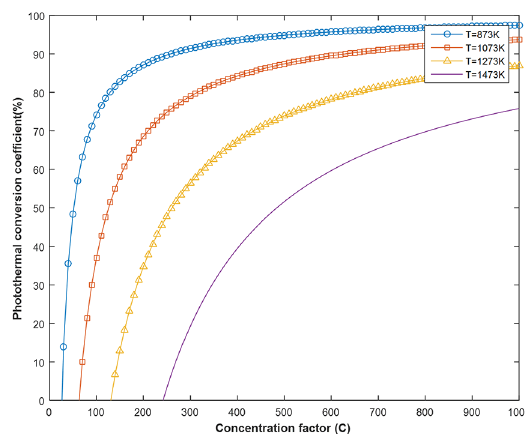
Figure 9. Photothermal conversion coefficient for different concentration factors and operating temperatures.